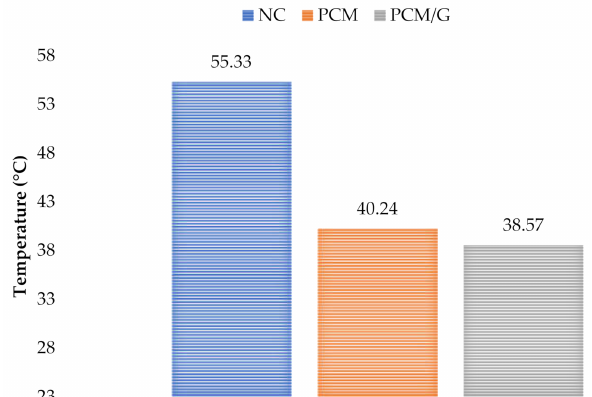
Figure 6. Comparison of the temperature evolution for three different scenarios, including natural convection (NC), PCM cooling, and PCM/Graphite cooling under 150 A current rate.